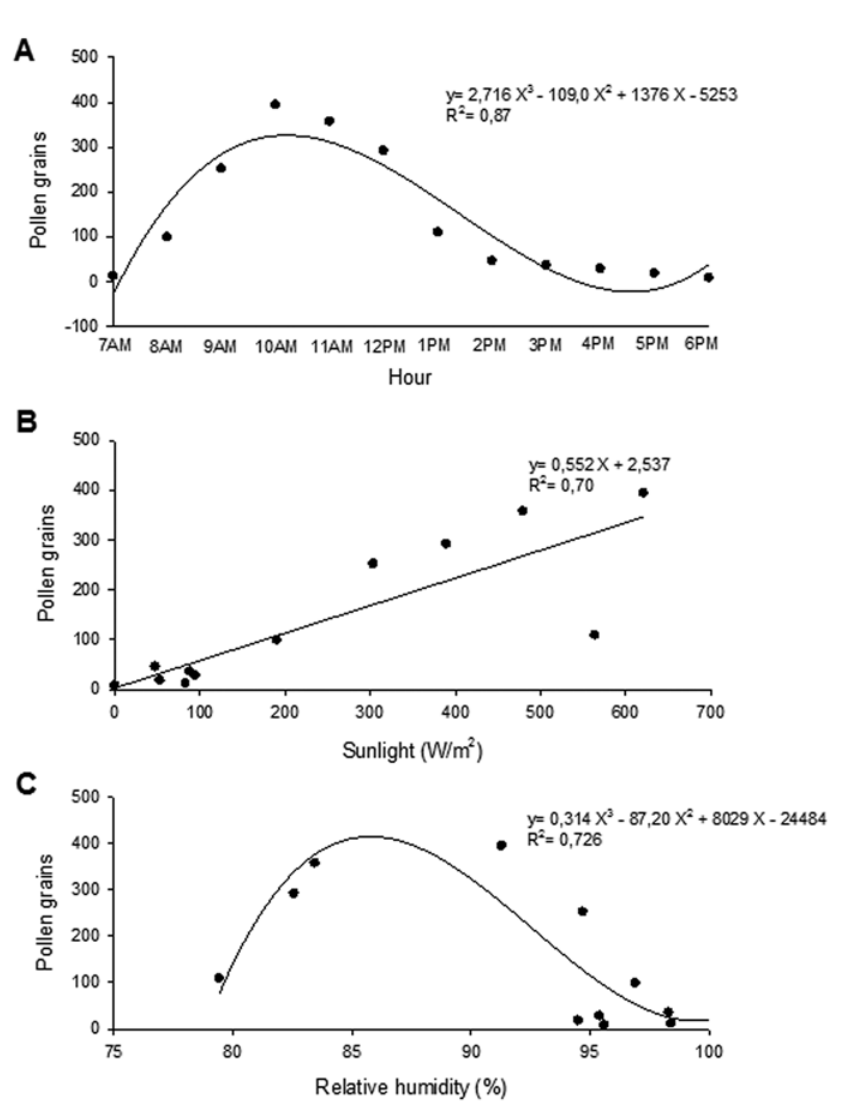
Fig.3 . Pollen grains collected per hour (A) , in function of the sunlight (B) and the relative humidity (C) in an Amazonian Rain Forest fragment in Sorriso, Mato Grosso –